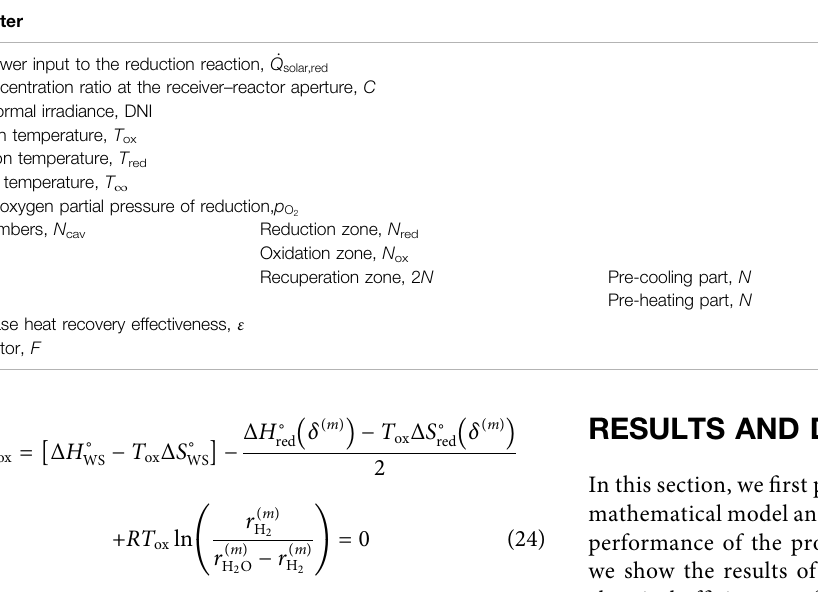
TABLE 1 | Baseline model